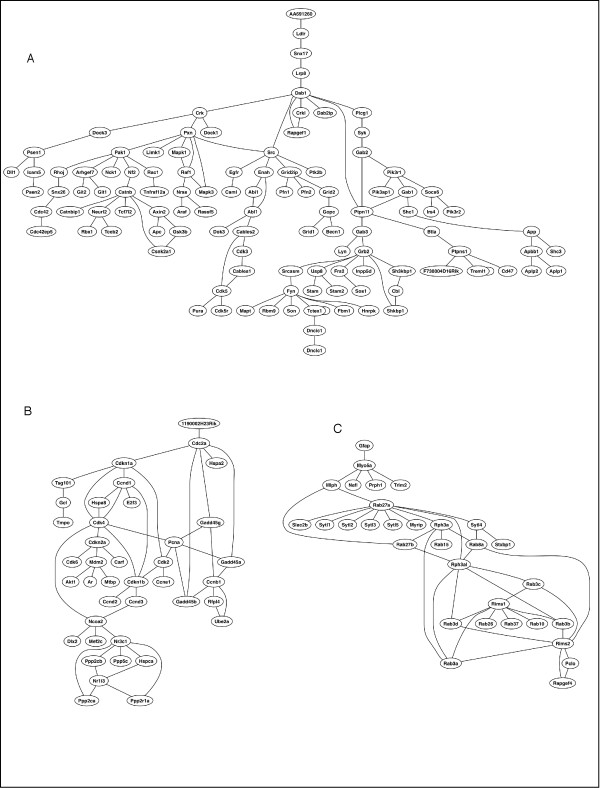
Interaction network maps showing 109 (A), 40 (B), and 31 (C) interacting proteins.